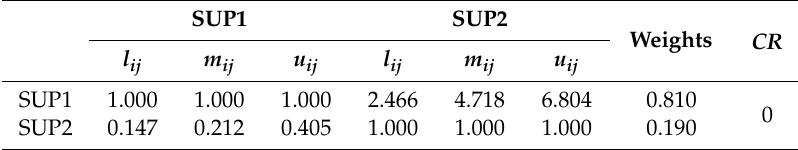
Table 5. Combined judgement matrix using geometric means for the subcriteria of the criterion Availability of support.